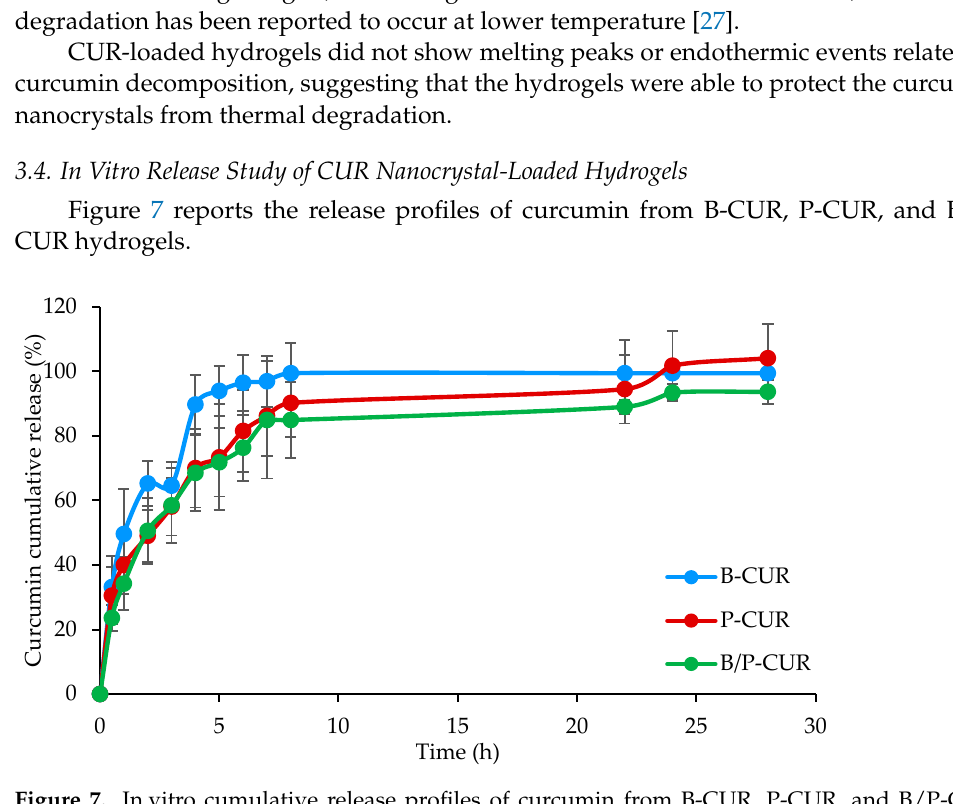
Figure 8. Radical scavenging activity (RSA%) of curcumin released from B-CUR, P-CUR, and B/P- CUR hydrogels (mean values ± s.d.; n = 3). * indicates significant differences ( p < 0.05).